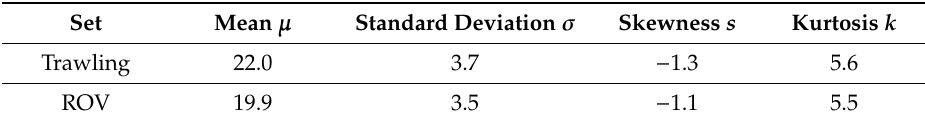
Figure 8. Comparison of the distribution of the number of polyp leaves in Pennatula rubra : in blue, samples obtained with trawling; in red, observations from Remotely Operated Vehicle (ROV) surveys. Table 1. Statistics of the number of polyp leaves of Pennatula rubra for trawling- and Remotely Operated Vehicle (ROV)-based